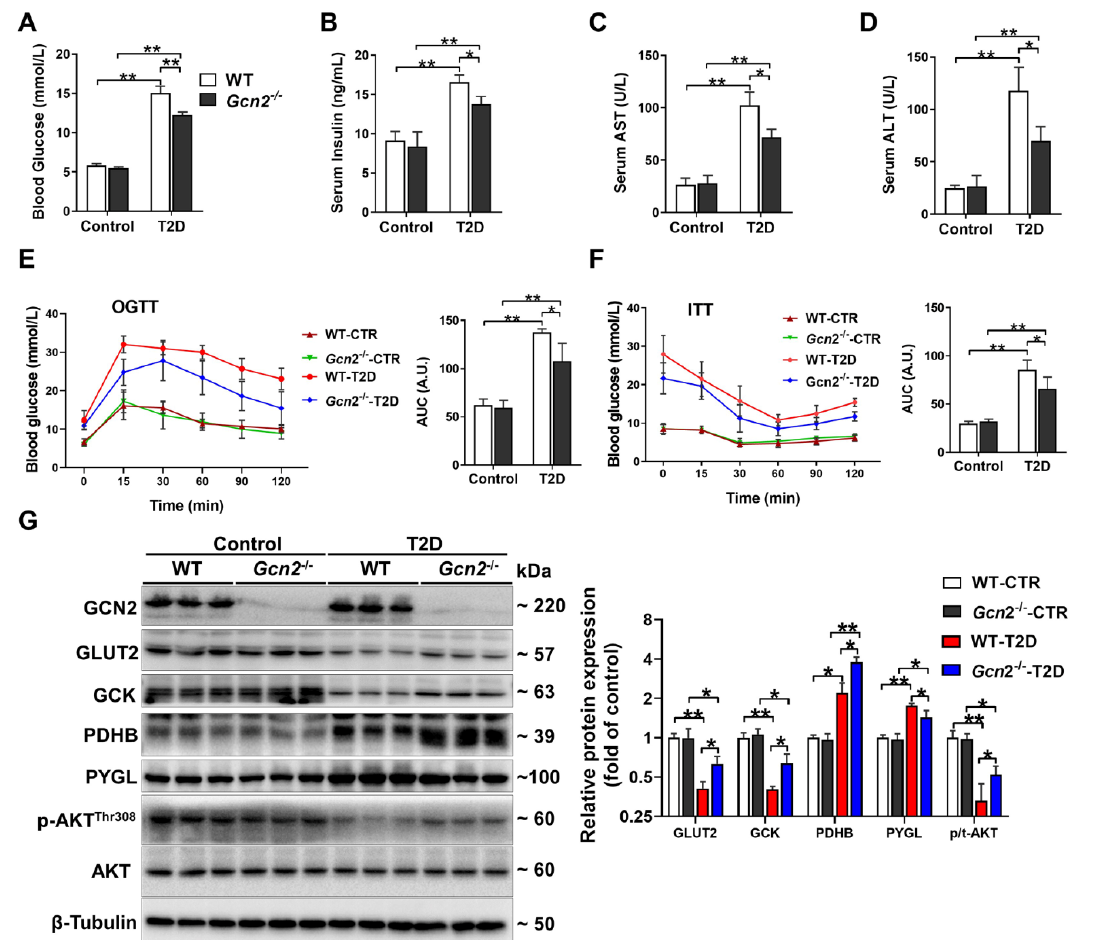
Figure 1. GCN2 deficiency alleviates liver dysfunction, hyperglycemia, and insulin resistance in type 2 diabetic mice. Type 2 diabetes (T2D) was induced in mice with a high-fat diet (HFD) plus low-dose streptozotocin (STZ) injection. At the end of the experiments, fasting blood glucose ( A ), serum insulin ( B ), aspartate transaminase (AST) ( C ), and alanine transaminase (ALT) levels ( D ) were measured. Oral glucose tolerance tests (OGTTs) ( E ) and insulin tolerance tests (ITTs) ( F ) were performed on WT and Gcn2 − / − mice in both the control and T2D groups. The corresponding area under the curve (AUC) values of blood glucose levels in each group were calculated. ( G ) Liver lysates were examined by Western blot. N = 5 ( A – F ) or 3 ( G ); values are means ± SD; * indicates p < 0.05; ** indicates p < 0.01.